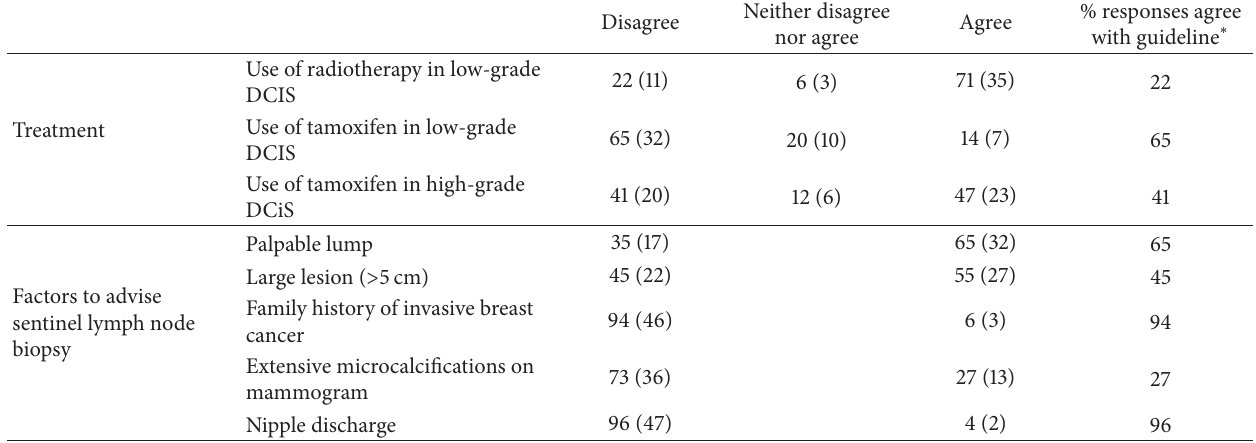
Table 4: Treatment and factors to advise sentinel lymph node biopsy and their agreement with guidelines (percentage in each group ( 𝑛 )). ∗ NICE guideline 2009 (early breast cancer)